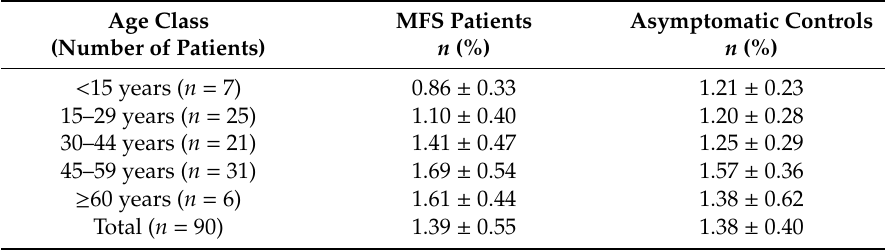
Table 3. Sonographic thickening of the muscularis propria in patients with MFS and the asymptomatic